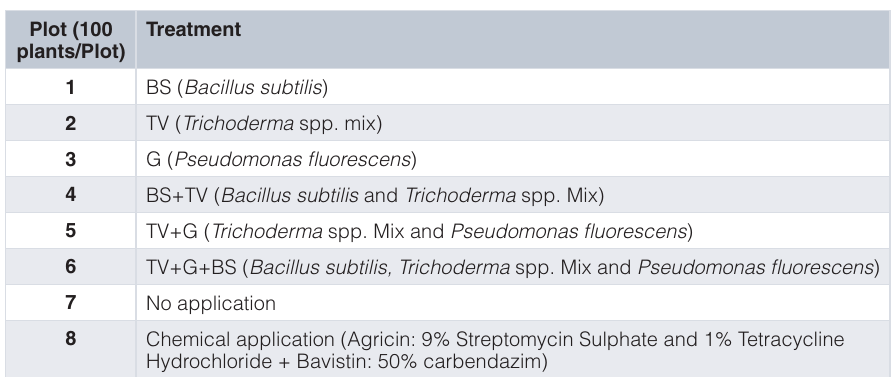
Table 2. Design of treatment plot to study the effect of different treatment methods on controlling the bacterial disease. One plot comprised of 100 tomato plants and 8 plots in total were studied; area of 50 m 2 per